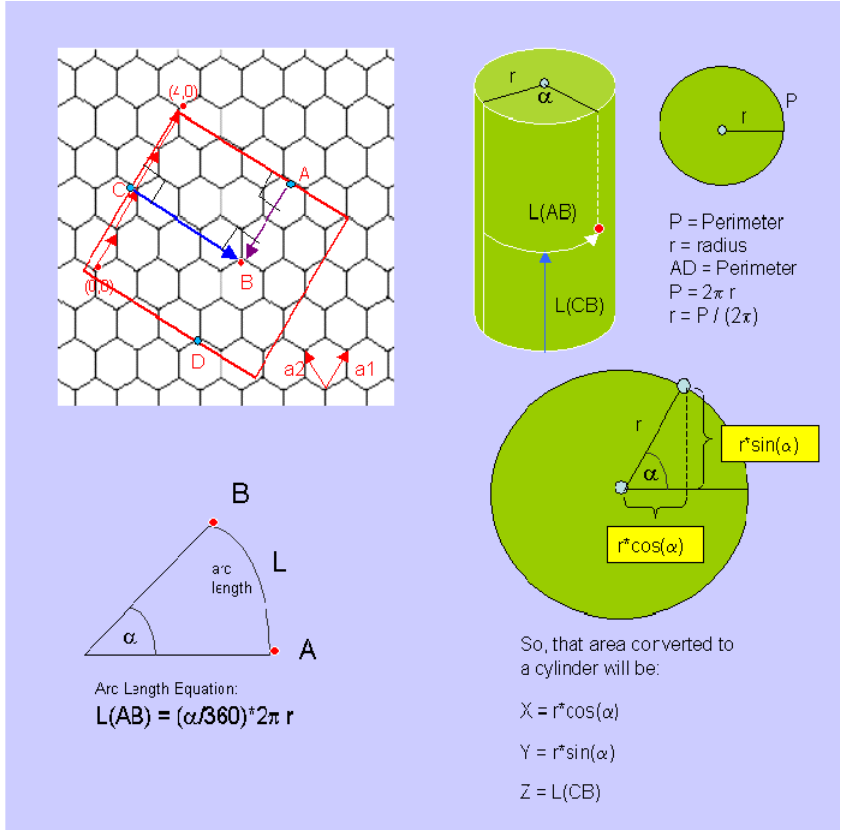
Figure 5. Schematic view representing the rolling up